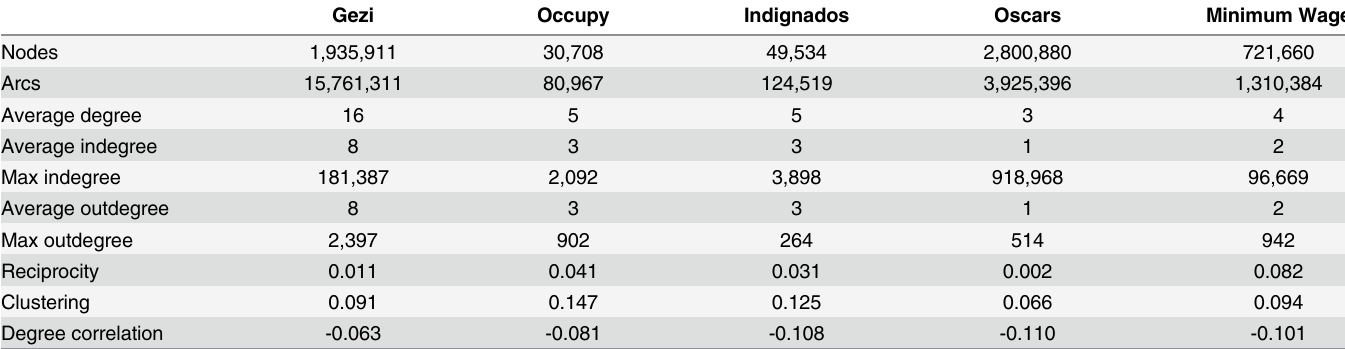
Table 1. Summary statistics for the three retweet networks analyzed (largest weakly connected component).